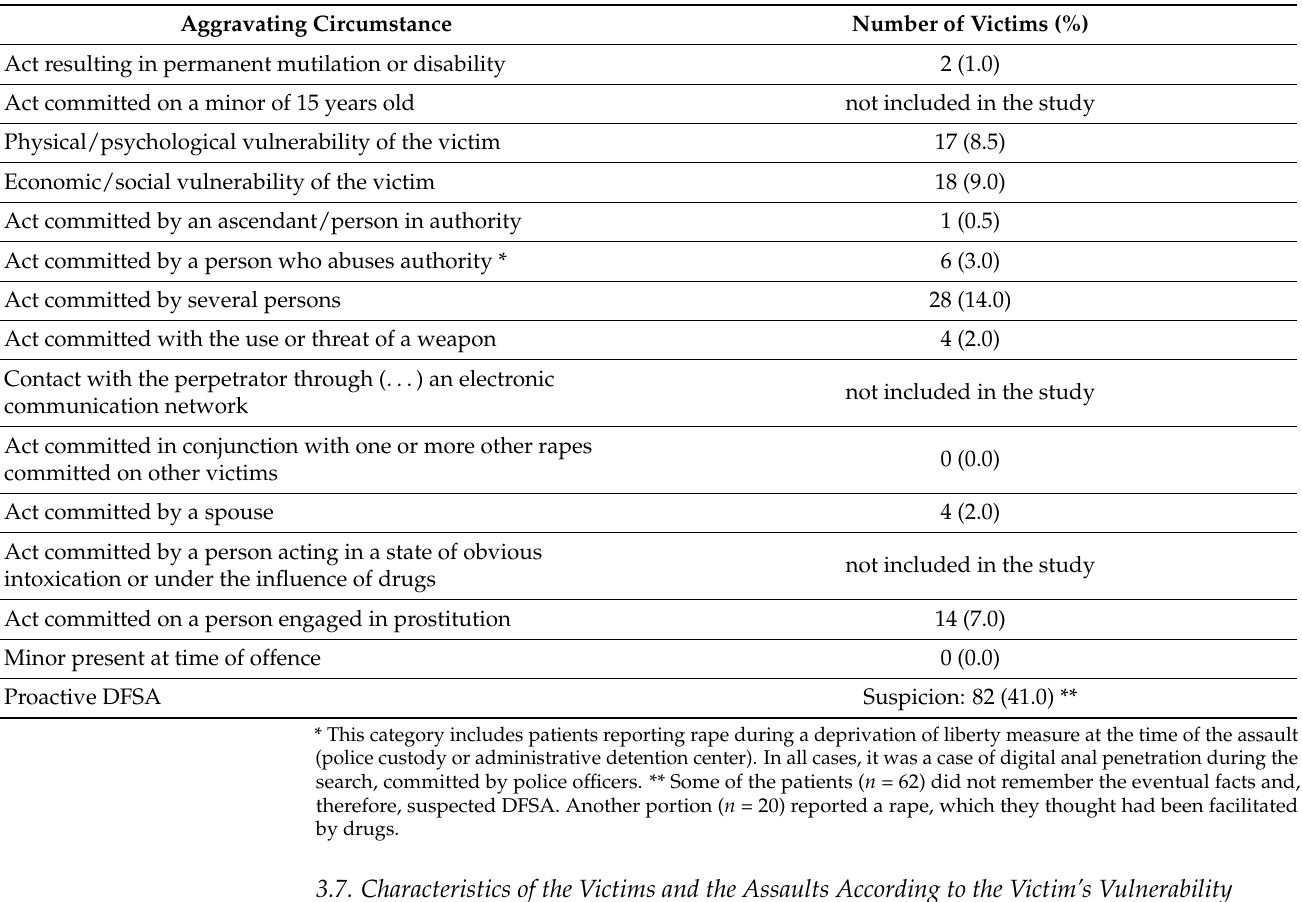
Table 1. Number of victims describing aggravating